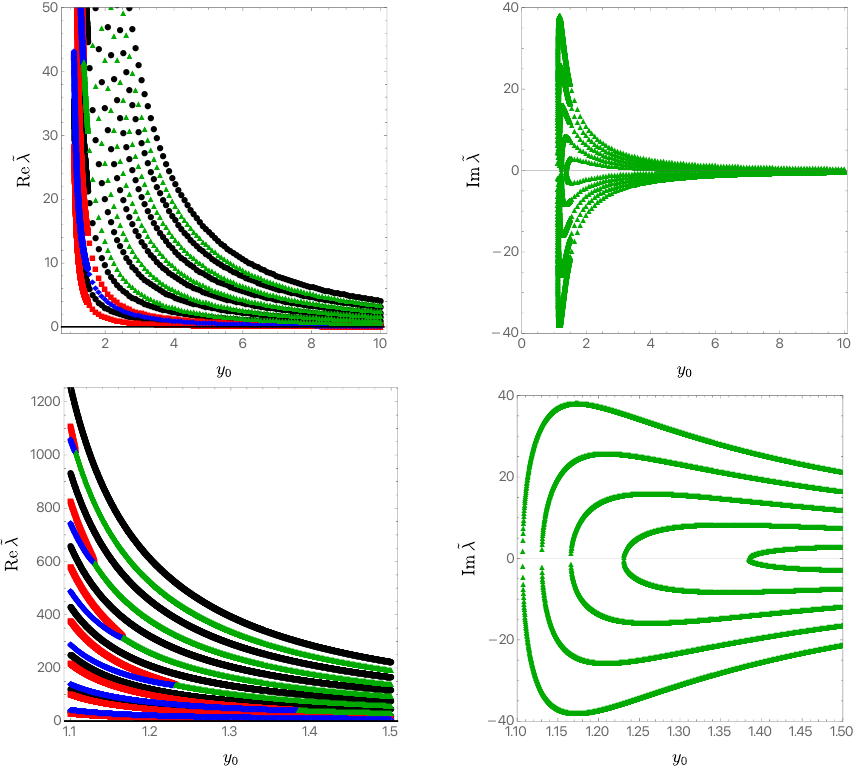
Figure 4 . The real part (left column) and the imaginary part (right column) of the excited modes as a function of y 0 for y 0. The figures in the bottom row show magnified versions of small ` “ regions from the figures in the top row. All plots are for d “ 4. The colour coding is as follows: green triangles are non-gauge modes with complex eigenvalues; blue diamonds are non-gauge modes with negative norm under ˆ G ; red squares are non-gauge modes with positive norm under ˆ G and the black disks are pure gauge modes. Each green triangle has a two-fold degeneracy since complex modes come in conjugate